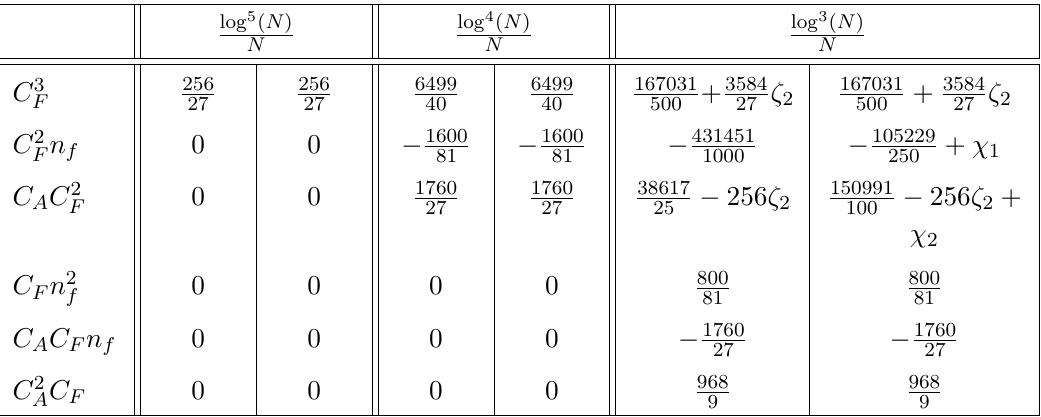
Table 2 . Comparison of 3-loop resummed predictions against exact results for the DIS structure function F 2 . For each color structure, the left column stands for the exact results and the right column stands for the resummed predictions. The constant χ 1 and χ 2 depends on ϕ (3)